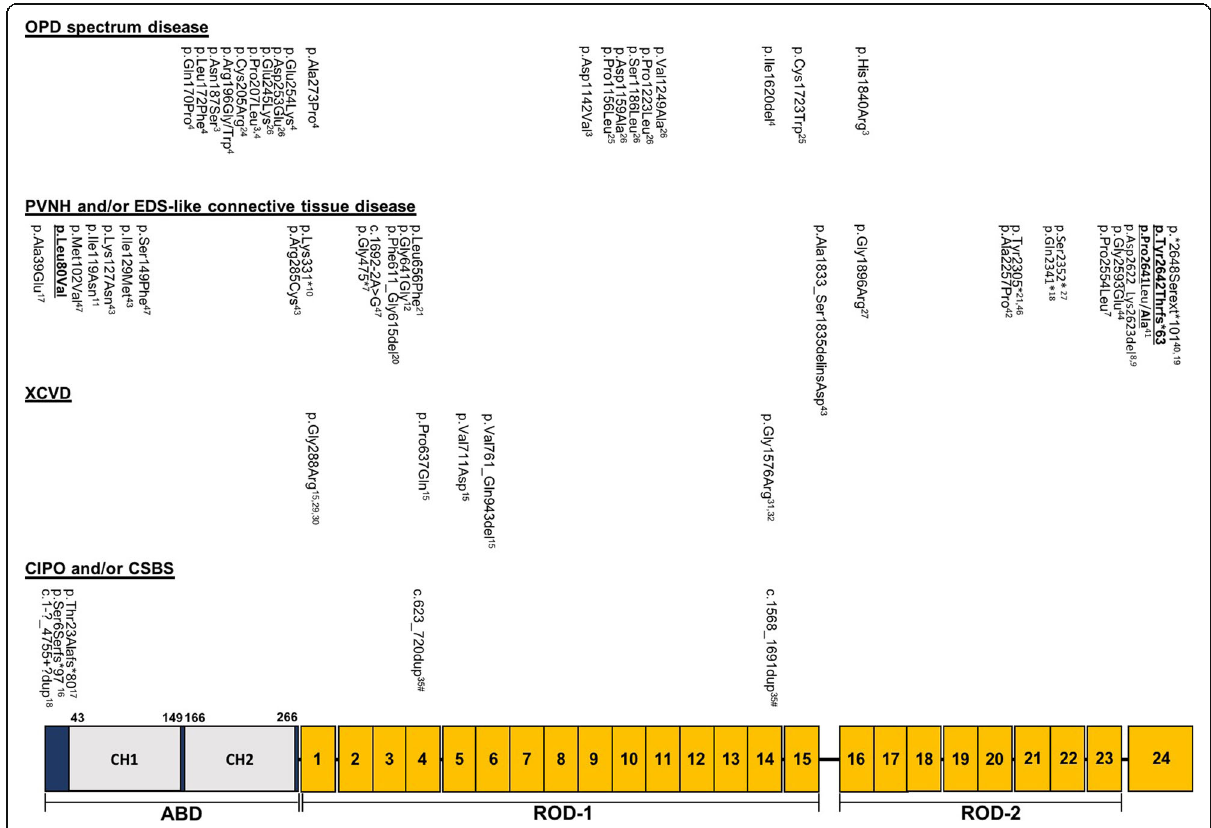
Fig. 1 Schematic representation of the FLNA domains and repeats and overview of FLNA mutations and their associated disorders. Each FLNA-related disorder and their causal mutations in live-born males is depicted separately. The four diseases indicate the primary clinical expression of the patients. Mutations in bold and underlined are identified within the current paper. Mutations indicated with # occur together in patients of the same